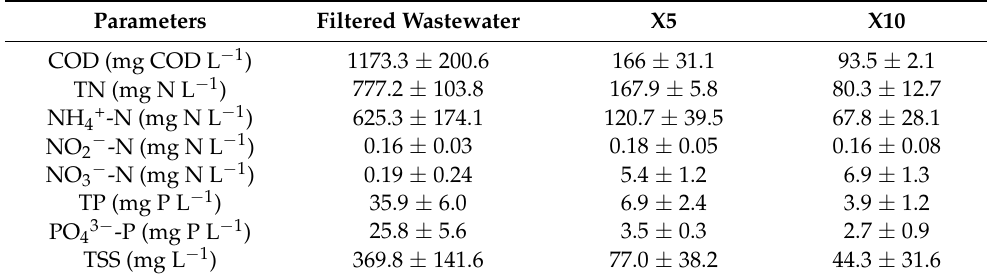
Table 1. Initial characteristics (average with standard deviation) of filtered biogas digestate and its diluted wastewater (X5 and X10 stand for 5- and 10- times dilution, respectively) used in this study.